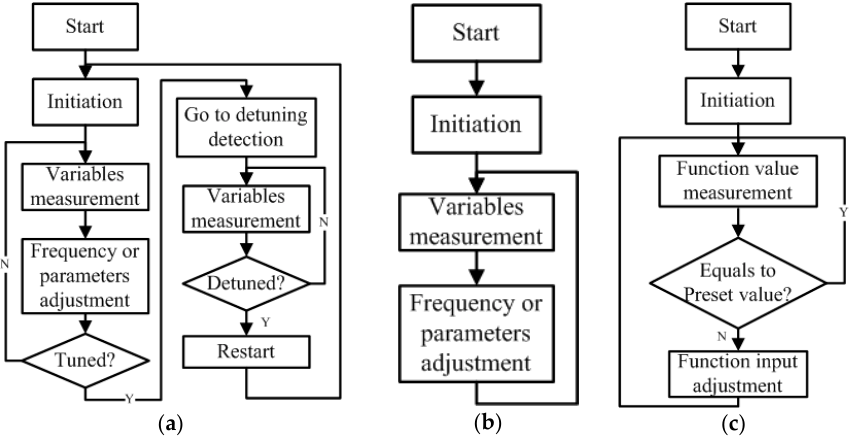
Figure 1. Flowcharts of tuning methods: ( a ) one ‐ off tuning with restart when detuned; ( b ) fully ‐ automatic tuning; and ( c ) tuning according to functions.